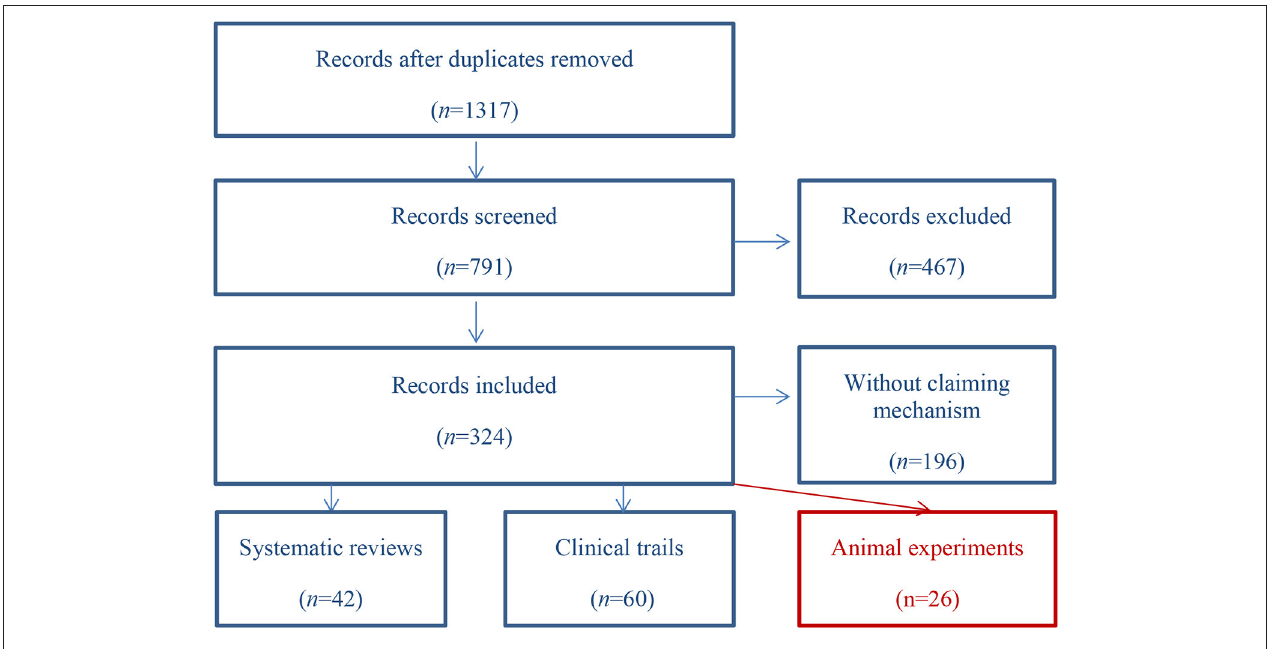
FIGURE 1 | Scanning path.